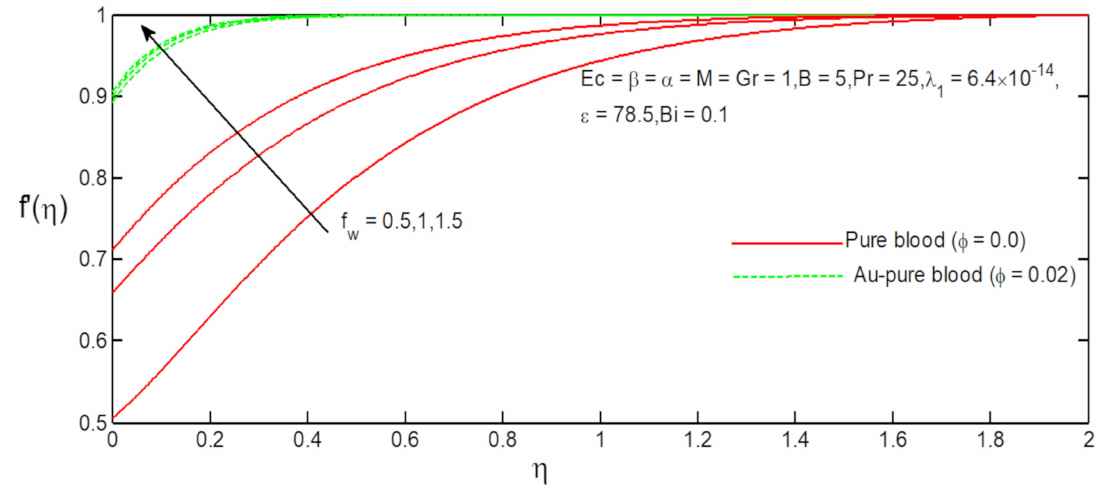
Figure 4. Influence of f w on f (cid:48) ( η )